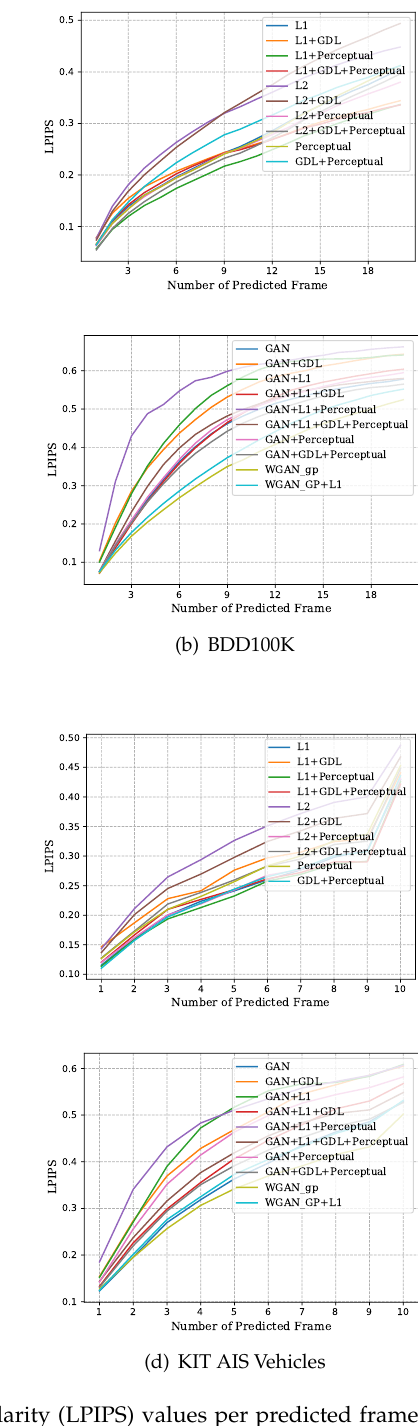
Figure 5. Mean learned perceptual image patch similarity (LPIPS) values per predicted frame for all evaluation datasets. (Small values are better.) To obtain these values, we used the models that were trained on Cityscapes for 20 epochs. The models were trained to predict the next frame based on four past frames. The results for the non-adversarial and the adversarial loss combinations are visualized separately for each dataset. The visualizations of the mean squared error (MSE), peak signal-to-noise ratio (PSNR), structural similarity index (SSIM), and Fréchet inception distance (FID) values are included in Appendix A and in the supplementary